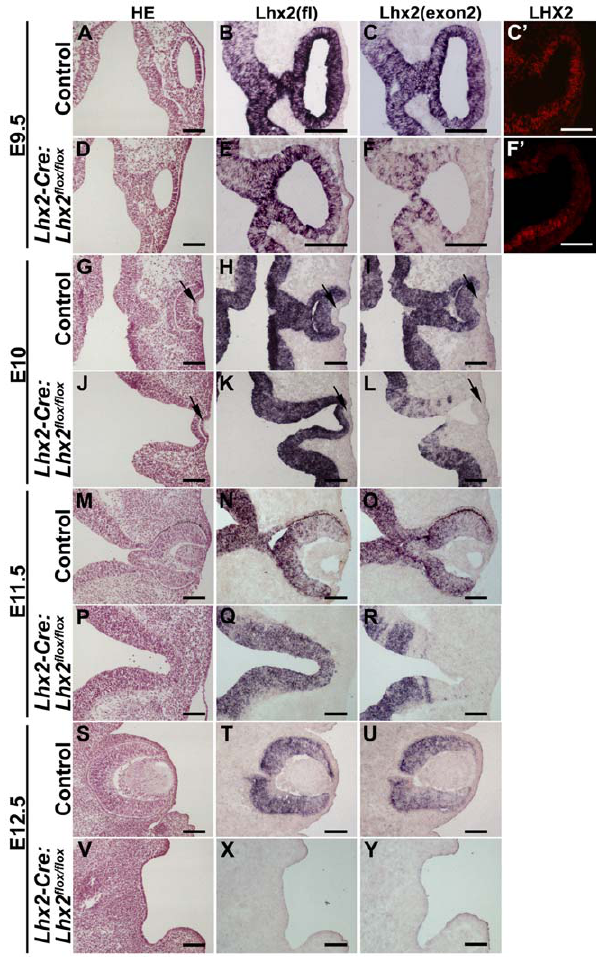
Figure 2. Conditional inactivation of Lhx2 in the eye-commit- ted progenitor cells leads to an immediate arrest in eye development. (A–F) Analyses of transversal sections of optic vesicles in E9.5 control (A–C) and mutant ( Lhx2-Cre:Lhx2 flox/flox ) (D–F) embryos. Hematoxylin/Eosin (HE) staining (A,D), in situ hybridisation analyses using a full-length (fl) Lhx2 probe (B,E), and a probe specific for exon 2 (exon2) (C,F). Wild-type Lhx2 mRNA hybridizes to both the fl and the exon 2 probe whereas mutant mRNA only hybridizes to the fl probe. (C 9 ,F 9 ) Immunohistochemical analysis on coronal sections of control (C 9 ) and mutant optic vesicle (F 9 ) confirming that no Lhx2 protein is detected in cells expressing mutant mRNA. Transversal (G–R) and coronal (S–Y) sections of embryos at the indicated developmental stages comparing eye development and expression of wild-type and mutant Lhx2 mRNA in control embryos to embryos where Lhx2 has been inactivated in the eye committed progenitor cells. Arrows indicate lens placode formation in the control and mutant embryos. Scale bars: Figure 3. Early patterning of the optic vesicle is initiated